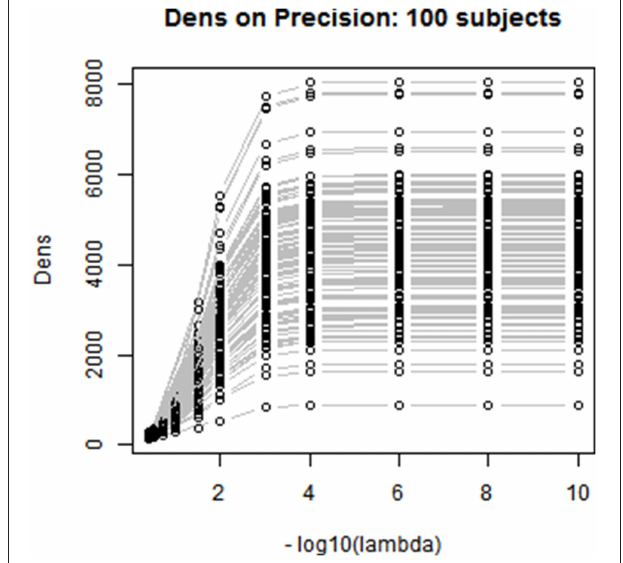
FIGURE 5 | Between-subjects consistency analysis for the proposed Dens-based method. We randomly selected 100 subjects to check the consistency of the proposed Dens method, where λ values are on the scale, ranging from 1e-10 to 0.4. As shown in the figure, Dens method is highly consistent across subjects serving as a reliable property to select the tuning parameters for large group level